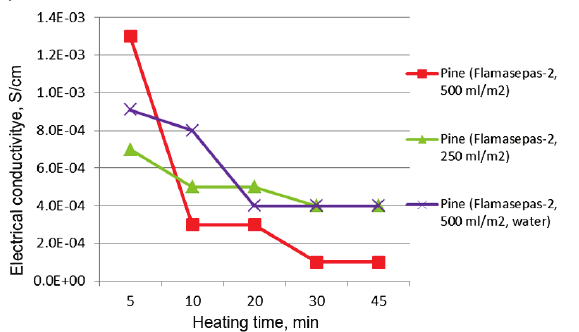
fig. 11. the dependency of the average electrical conductivity on heating time for media 9, 10 and